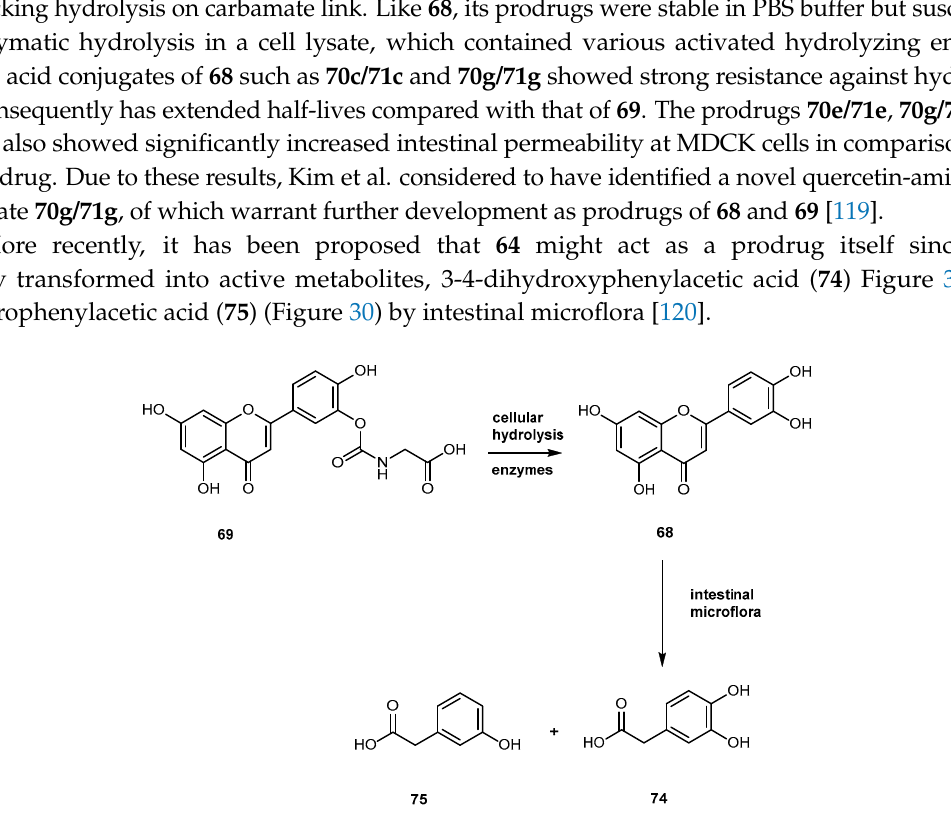
Figure 31. Chemical structure of docetaxel ( 76 ) and its novel prodrug LK-196.